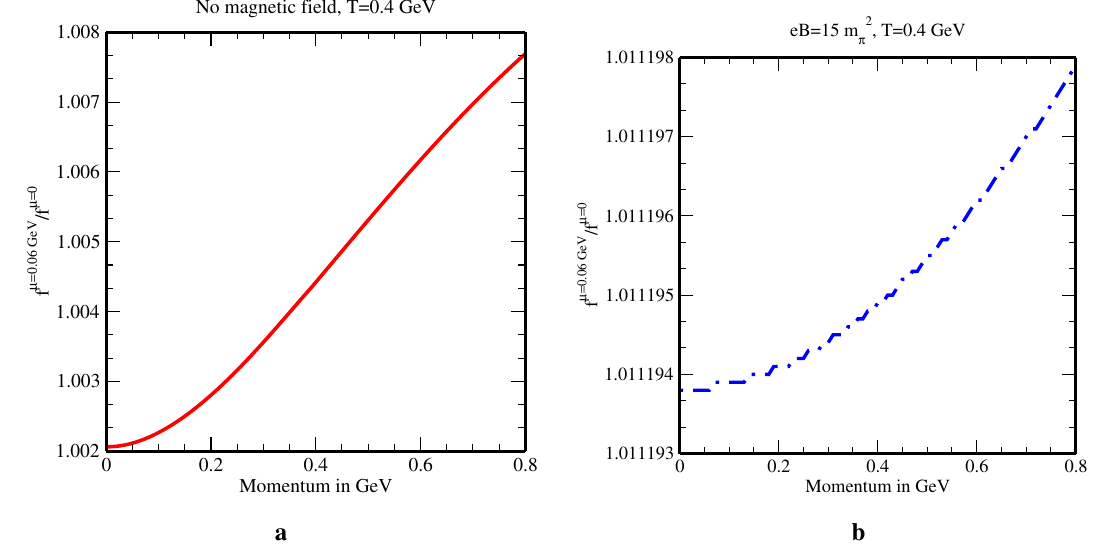
Fig. 2 Variations of the ratio of quark distribution function at μ = 0 . 06 GeV to its value at μ = 0 with momentum at high temperature in the a absence and b presence of strong magnetic